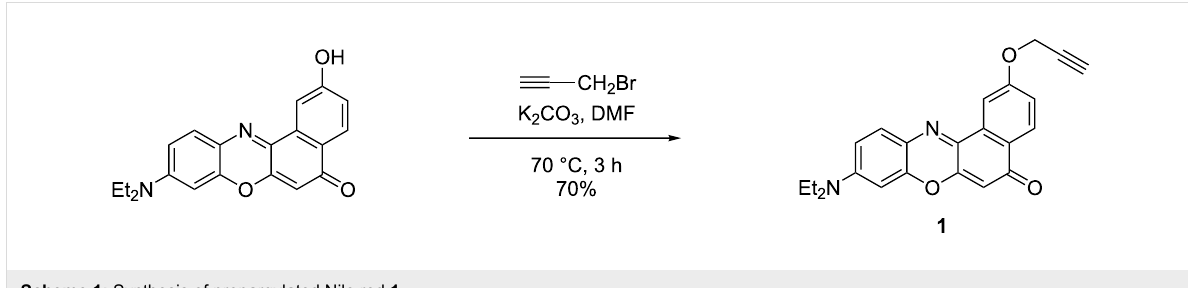
Scheme 1: Synthesis of propargylated Nile red 1